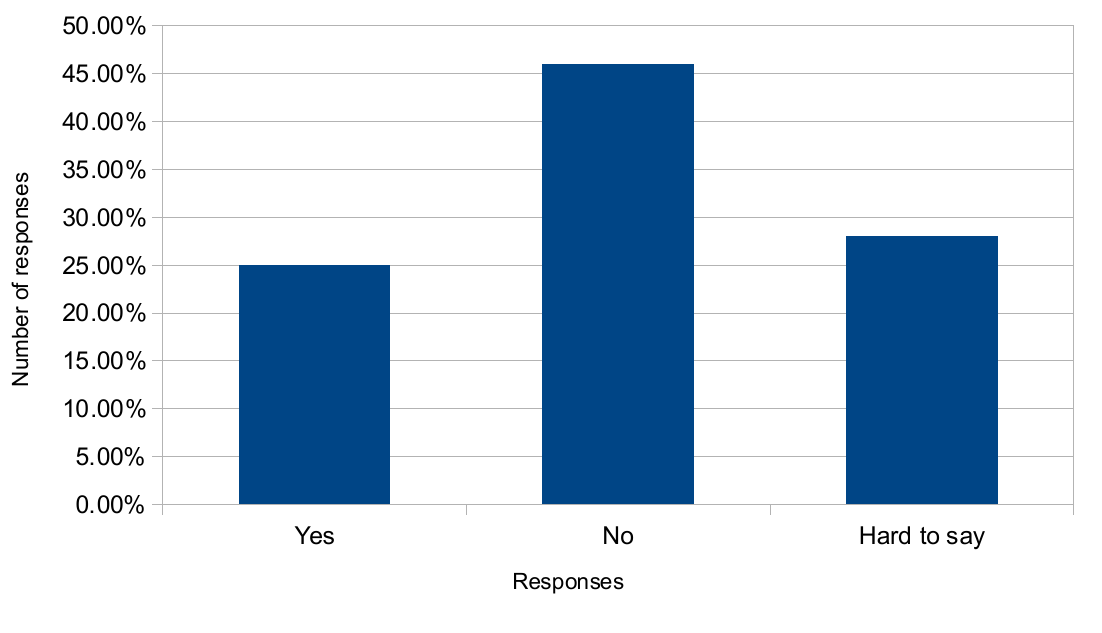
Figure 2. The possibility of early recognition of symptoms of ADHD